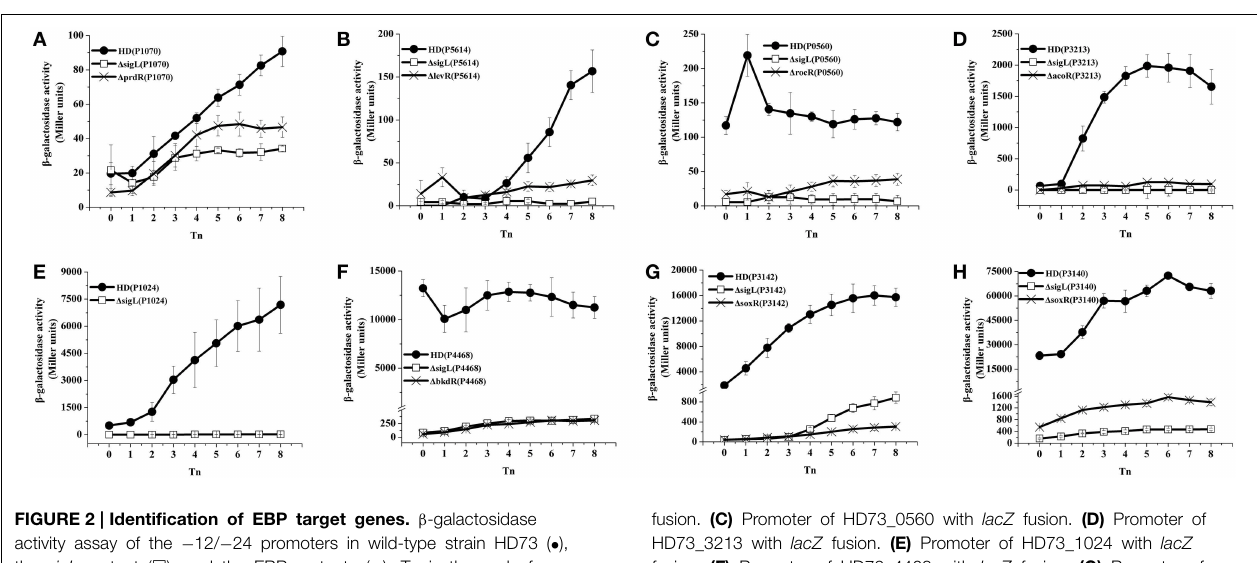
FIGURE 2 | Identification of EBP target genes. β -galactosidase activity assay of the − 12/ − 24 promoters in wild-type strain HD73 ( • ), the sigL mutant ( (cid:3) ), and the EBP mutants ( × ). T 0 is the end of exponential phase, and Tn is n hours after T 0 . (A) Promoter of HD73_1070 with lacZ fusion. (B) Promoter of HD73_5614 with lacZ